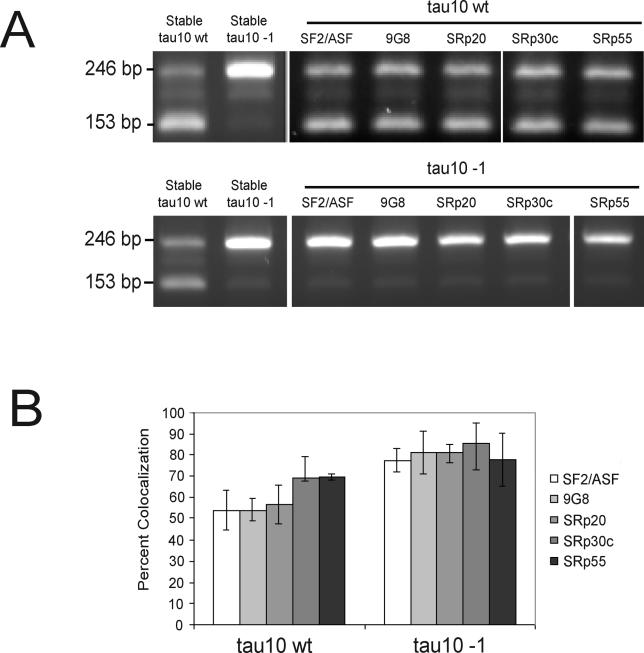
Differential Recruitment of Exogenous Pre-RNA Splicing Factors to tau Minigenes(A) Semi-quantitative RT-PCR analysis of tau alternative splicing upon expression of T7-tagged SR proteins in COS-7 cells expressing either tau10wt or tau10−1. Transient transfection of splicing factors does not affect the alternative splicing pattern of the tau minigene in stable cell lines.(B) Quantitative analysis of recruitment of transfected SR proteins to tau10wt or tau10−1. Recruitment of splicing factors to tau transcription sites detected by combined RNA-FISH using specific probes against the tau minigene and IF microscopy with anti-T7 antibody. Percentage of cells with colocalization of tau RNA-FISH and splicing factor signals is indicated. Values represent averages from at least 100 transcription sites from three experiments ± SEM.